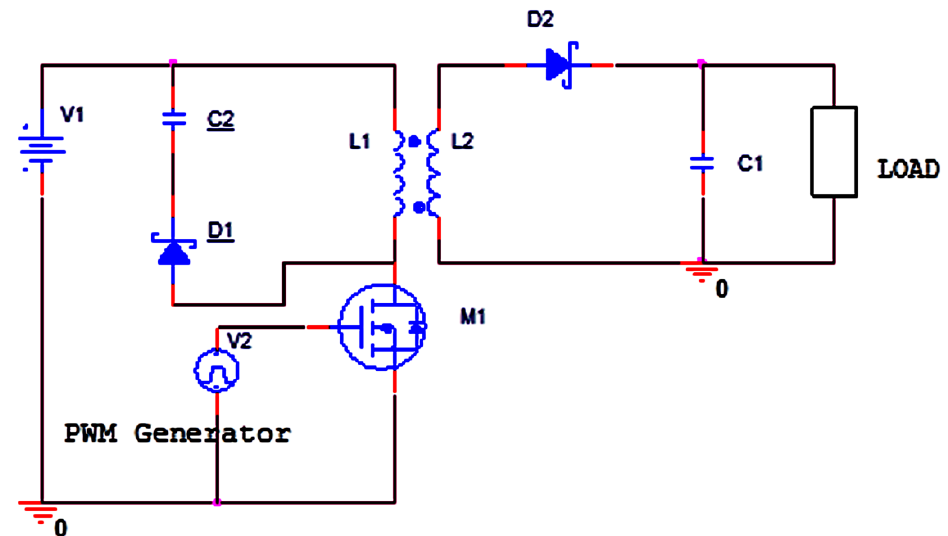
Figure 3. GaN-based active-clamp flyback converter topology with DC source, PWM generator, and load at the output.